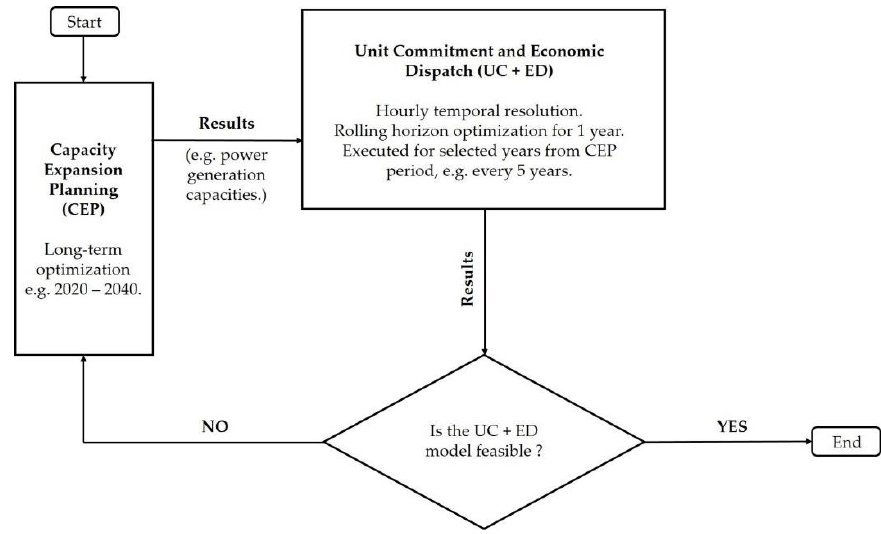
Figure 1. Flowchart illustrating the proposed framework for power system planning.